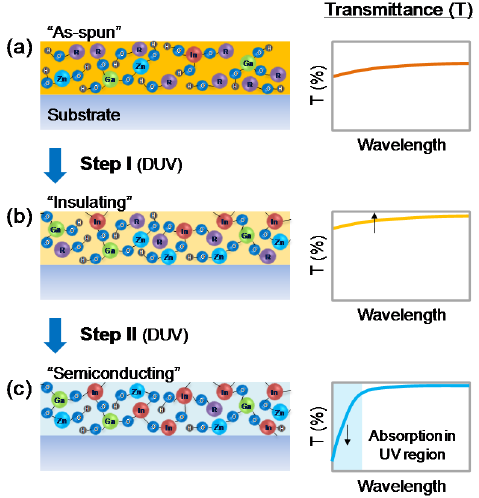
Figure 1. Schematics showing the evolution of a metal-oxide semiconductor film during the photochemical activation: ( a ) an as-spun film (insulating state); ( b ) after a short deep ultraviolet (DUV) irradiation (insulating state); and ( c ) after sufficient metal-oxygen-metal (M–O–M) network formation (semiconducting state).